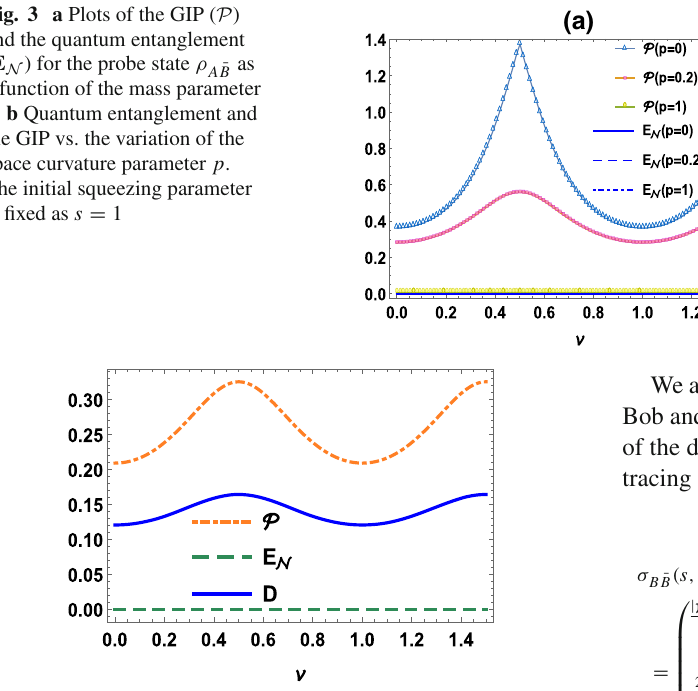
Fig. 4 Thevariationfunctionsofquantumdiscord(bluesolidline),the GIP (orange dotted line) and entanglement (green dotted line) between Aliceandanti-Bobvs.themassparameterofthefield.Otherparameters are fixed as s = 1 and p = 0 .